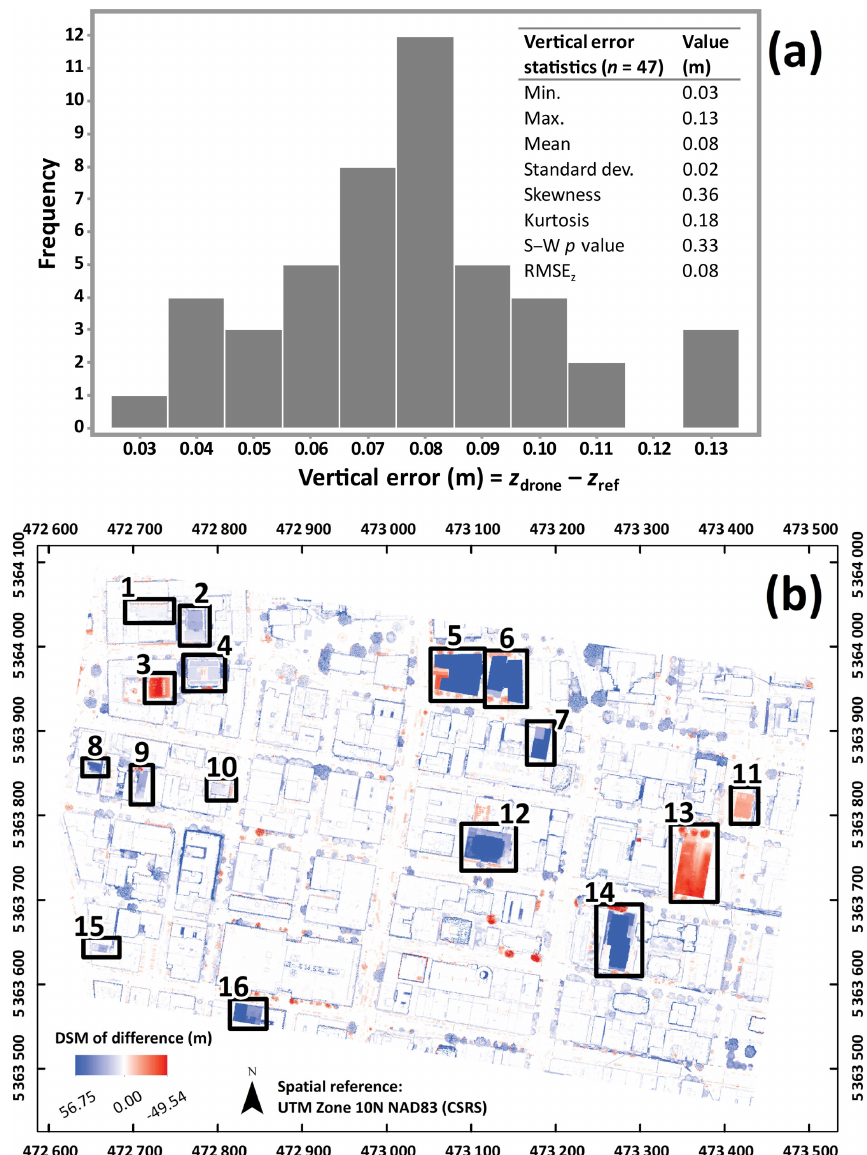
Figure 1. Geospatial accuracy results for the slow PPK-corrected drone DSM: (a) a vertical error histogram with statistics and the Shapiro– Wilk (S–W) p value and (b) the DSM of difference, calculated by subtracting DSM lidar from DSM drone . Blue tints represent elevation overestimations and red tints represent elevation underestimations by DSM drone . Buildings with major contiguous DSM differences are boxed in black. The causes of these contiguous DSM differences are due to changes during the 5 years between the lidar (2013) and drone